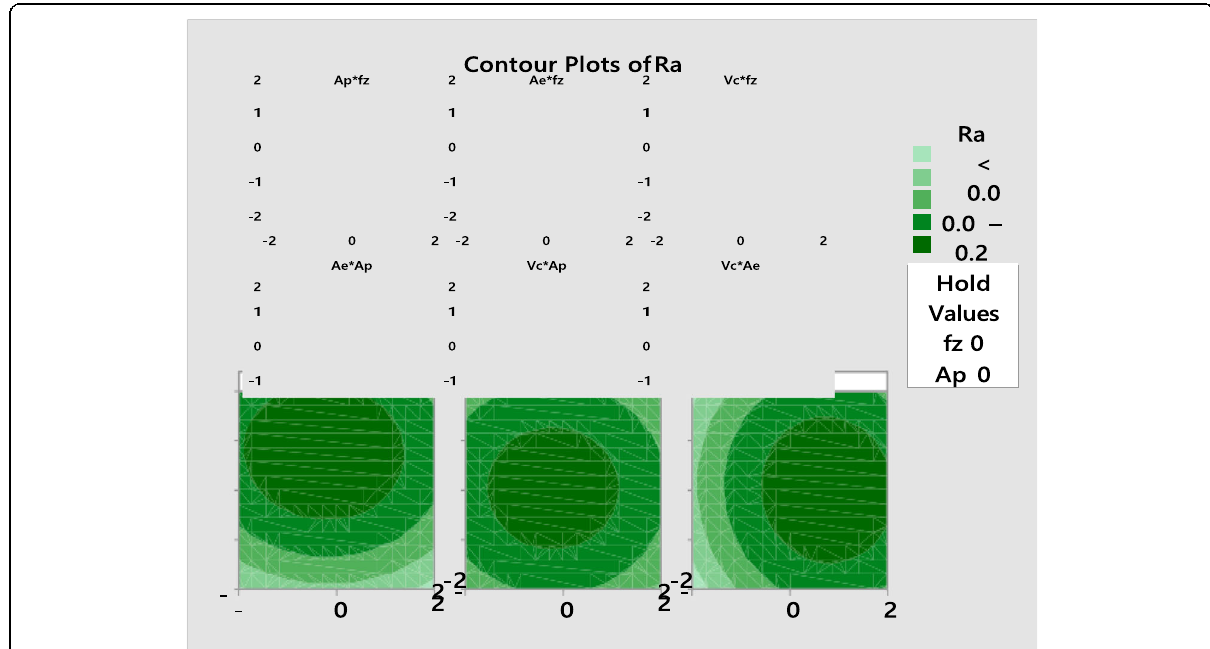
Fig. 9 Interaction effect contour plots for R